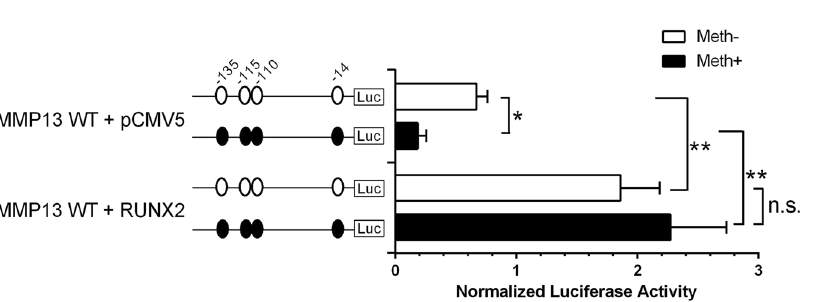
Figure 4. Long-term exposure to 5-aza-dC enhances RUNX2 gene expression associated with DNA demethylation at the − 336-bp CpG site. ( A ) Relative mRNA levels of RUNX2 were analysed by qRT-PCR and normalized against GAPDH in untreated (control) and 5-aza-dC-treated cultures. ( B ) Percentage methylation of indicated CpG sites in the RUNX2 P1 promoter was analysed using bisulfite pyrosequencing in the same samples. ( C ) The relative mRNA levels of MMP13 were analyzed in the same samples. Values represent mean ± SD of 6 independent experiments. * P < 0.05, ** P < 0.01.